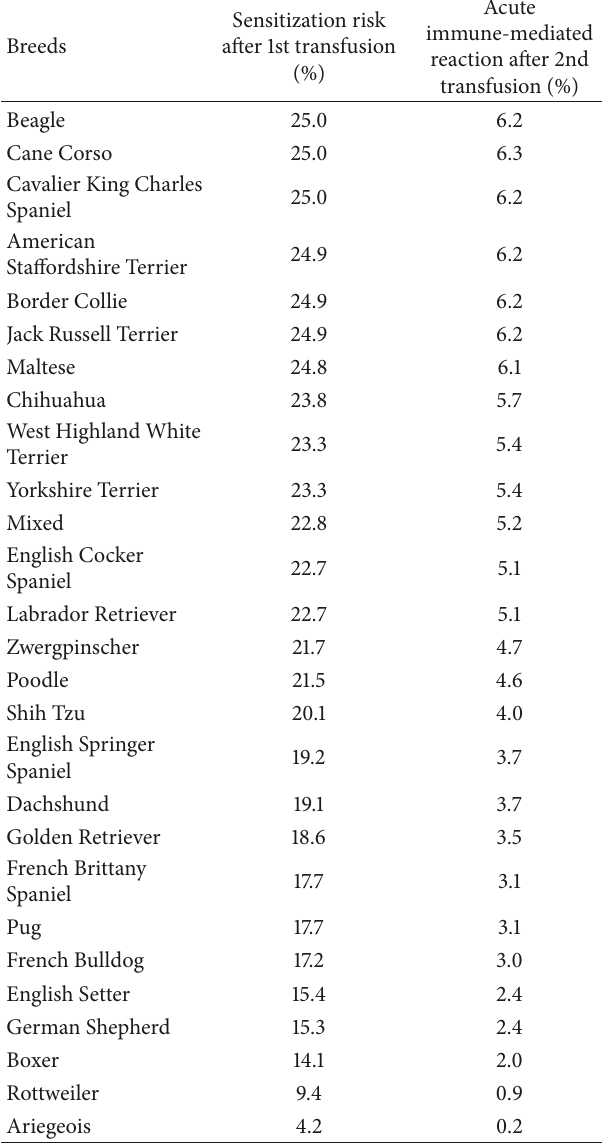
Table 5: The risk of sensitization after 1st transfusion and the risk of an acute hemolytic reaction after 2nd transfusion in the absence of pretransfusional cross-match and blood typing test §